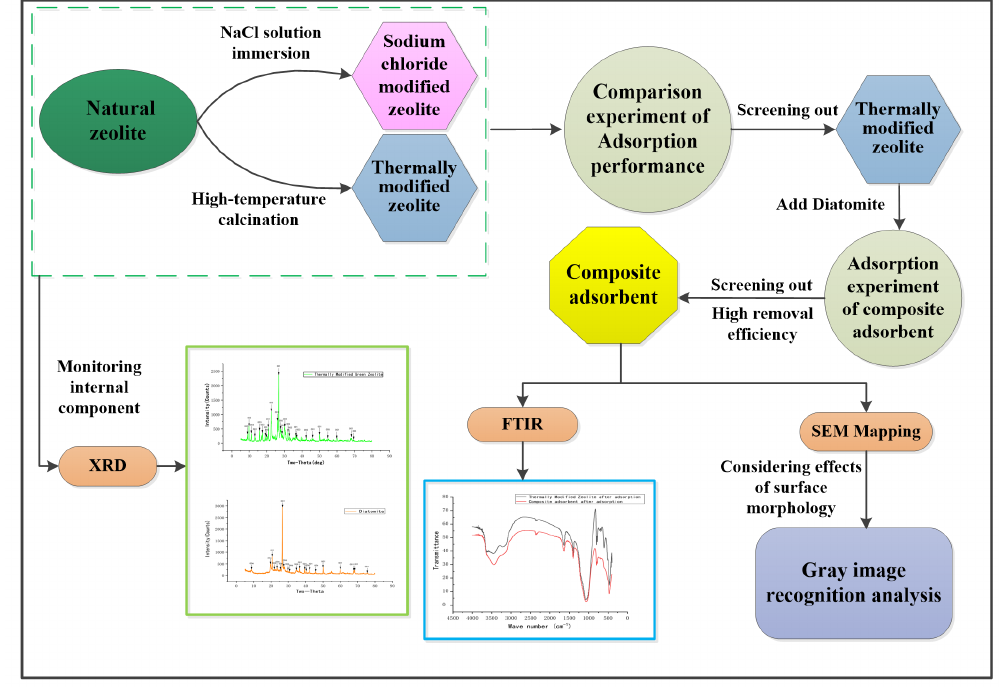
Figure 1. Research